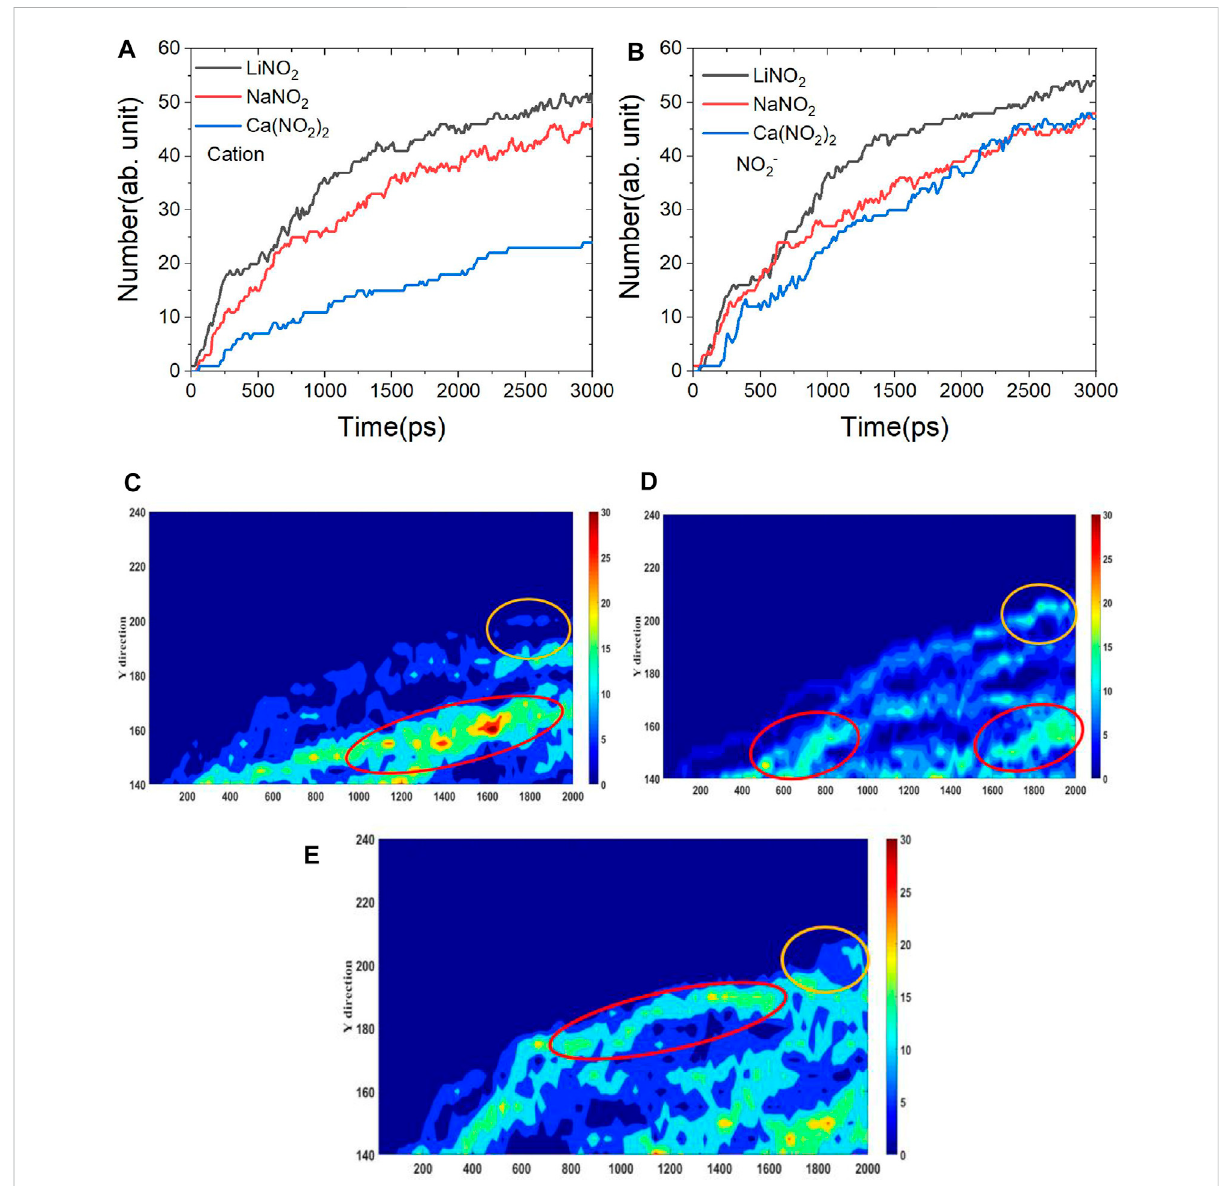
FIGURE 9 The schematic diagram of the number of ions entering the CSH channel over time (A) cations, (B) NO 2 − , the evolution of NO 2 − concentration distribution of three kinds of nitrite solutions: (C) NaNO 2 , (D) Ca(NO 2 ) 2 , (E) LiNO 2 . The red circle represents the depth of ion aggregation and the yellow circle represents the fi nal depth of ion